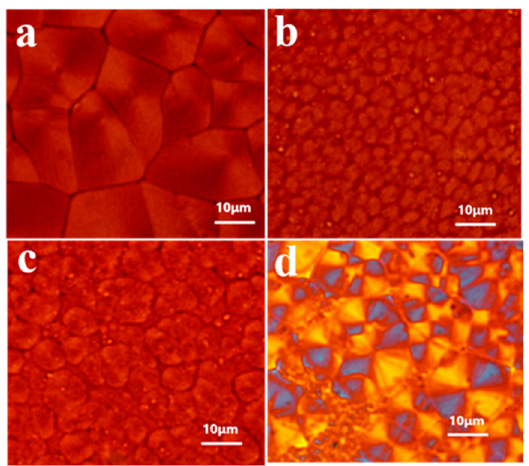
Figure 7. Isothermal crystallization morphology of ( a ) pure PVDF, ( b ) PVDF/20 nm 0.5 wt% SiO 2 , ( c ) PVDF/30 nm 0.5 wt% SiO 2 , and ( d ) PVDF/50 nm 0.5 wt% SiO 2 .